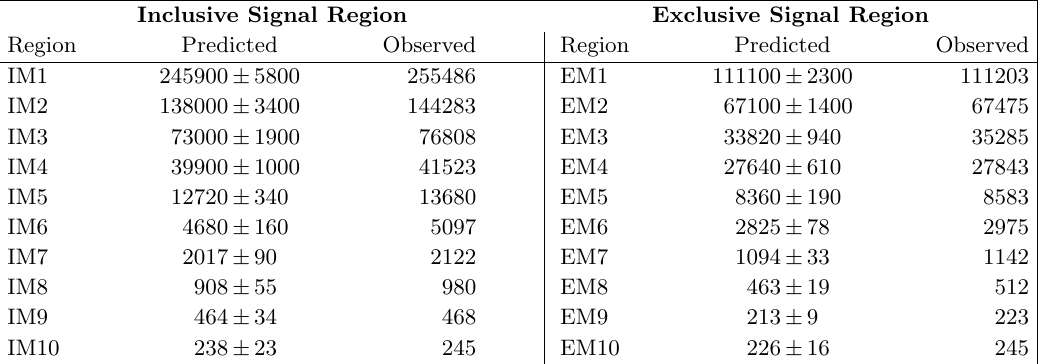
Table 5 . Data and SM background predictions in the signal region for the di(cid:11)erent selections. For the SM predictions both the statistical and systematic uncertainties are included.